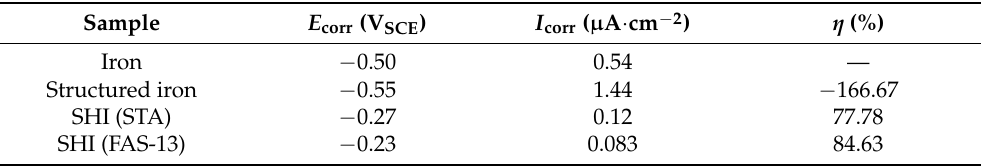
Table 1. Self-corrosion potential, self-corrosion current and calculated corrosion rate of different treated samples.